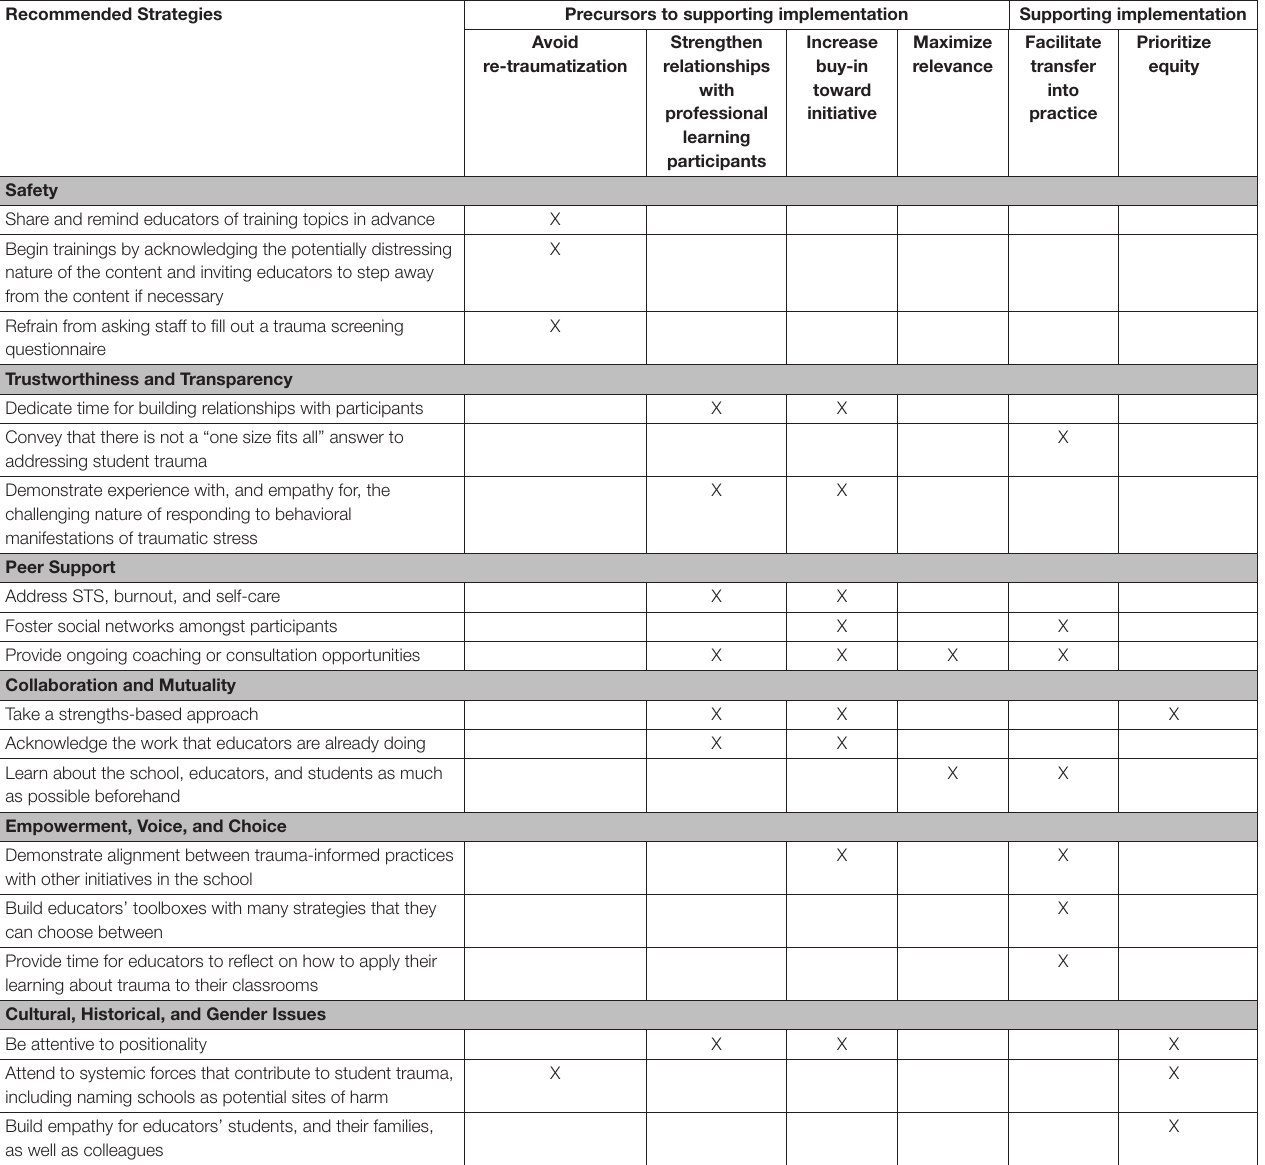
TABLE 1 | Alignment of recommended strategies with implementation supports of trauma-informed